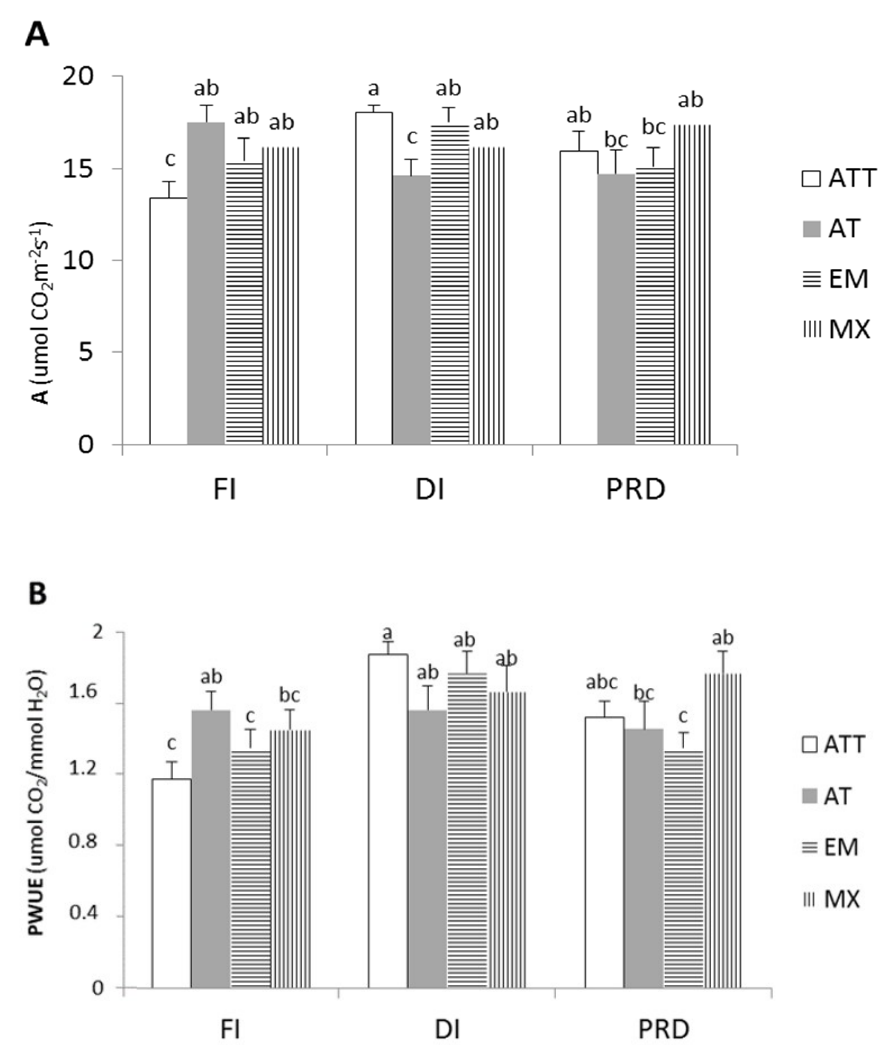
Figure 1. Photosynthetic rate ( A , B ) photosynthetic water-use efficiency—PWUE of grafted tomato plants grown with one or two stems under three irrigation techniques. Vertical bars represent SE values ( n = 6). a—significant difference by the LSD test at p ≤ 0.05 are indicated by different letters above column; ATT—one-stem Attiya; AT—two-stem Attiya; EM—Emperador, MX—Maxifort.